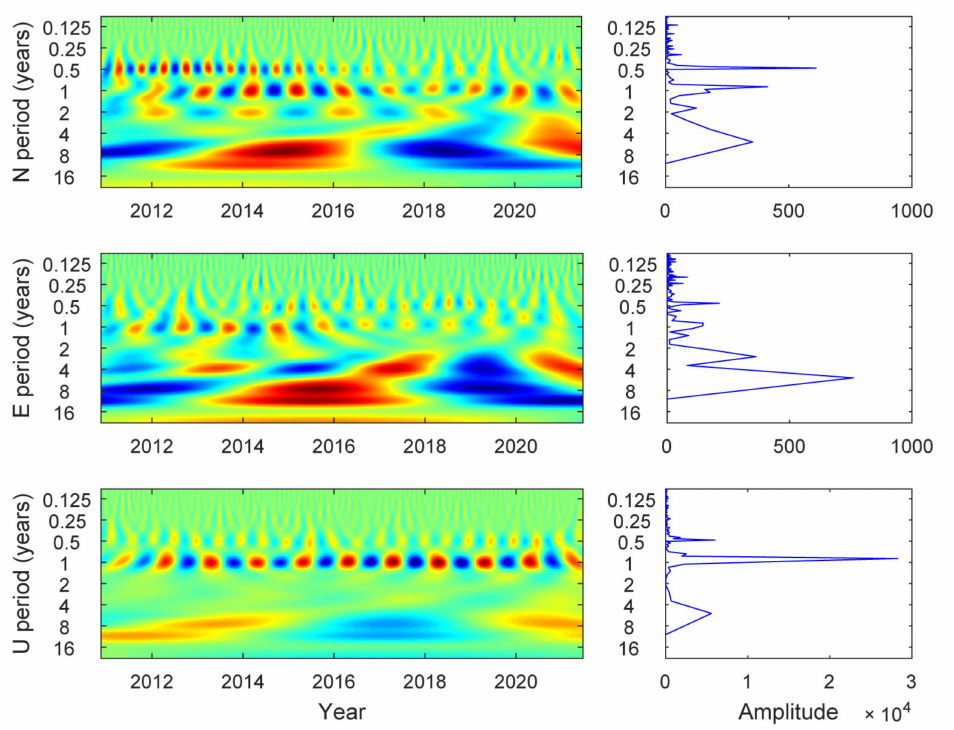
Figure 2. SCPZ station GNSS time series Morlet wavelet transform ( left) , where red means peak and blue means trough; and its spectrum ( right ).